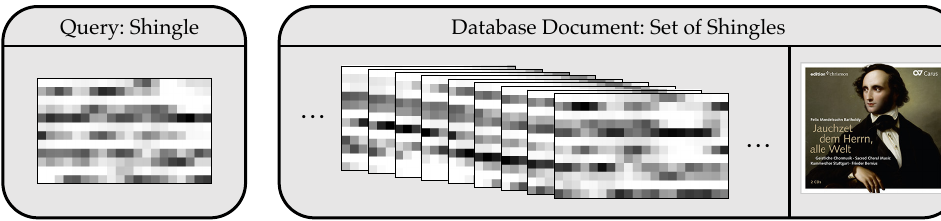
Figure 2. Illustration of shingle-based query and database